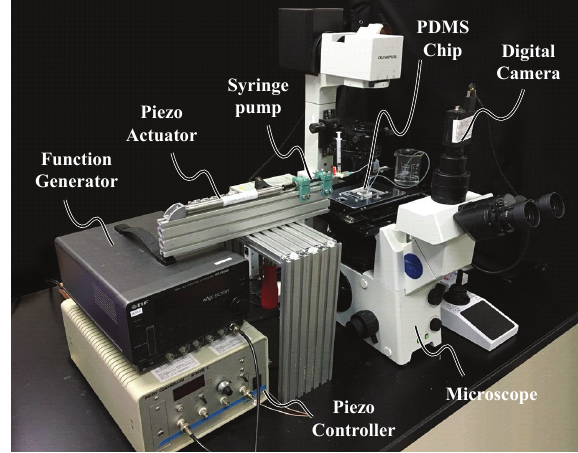
Figure 3. Experimental setup.